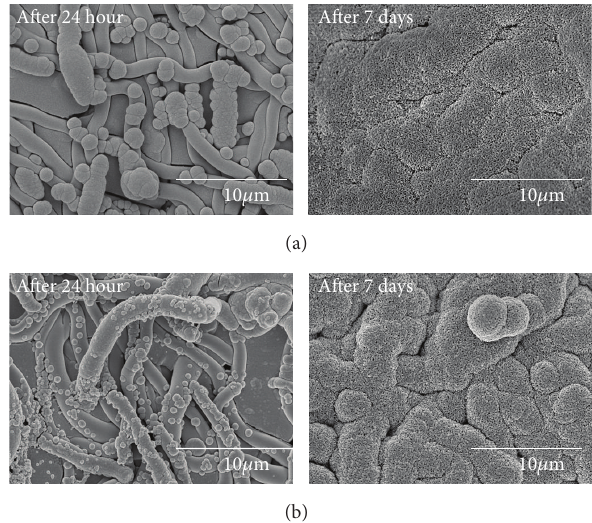
Figure 4: FE-SEM photographs showing the surface appearances of the fibrous PDLLA after immersion in HBS solution. (Original magnification 5,000x.) (a) PDLLA-R; (b)